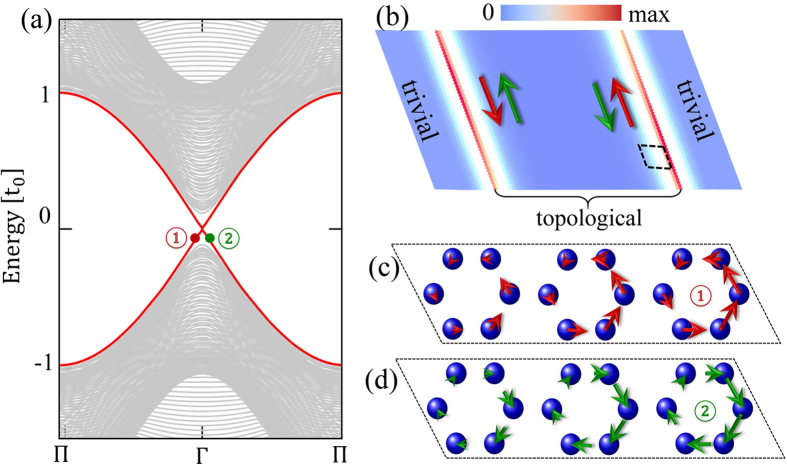
Topological edge states.(a) Band dispersion of a ribbon system of 36 hexagons with t1 = 1.1t0 cladded from both sides by 10 hexagons with t1 = 0.9t0. (b) Real-space distribution of the in-gap states associated with the red solid dispersion curves in (a). (c,d) Real-space distributions of current densities in pseudospin-up and -down channels at the momenta indicated by the red and green dots 1 and 2 in (a) within the rhombic area sketched by dashed line in (b); the excess currents in pseudospin-up and -down channels are indicated by red and green arrows in (b).